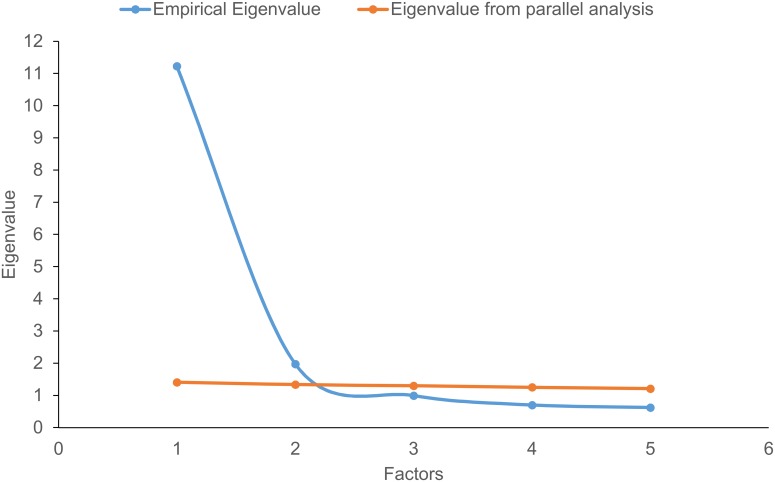
Empirical eigenvalues of the first and the second factor.